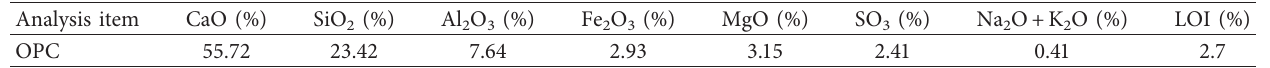
Table 1: Physical properties of OPC.